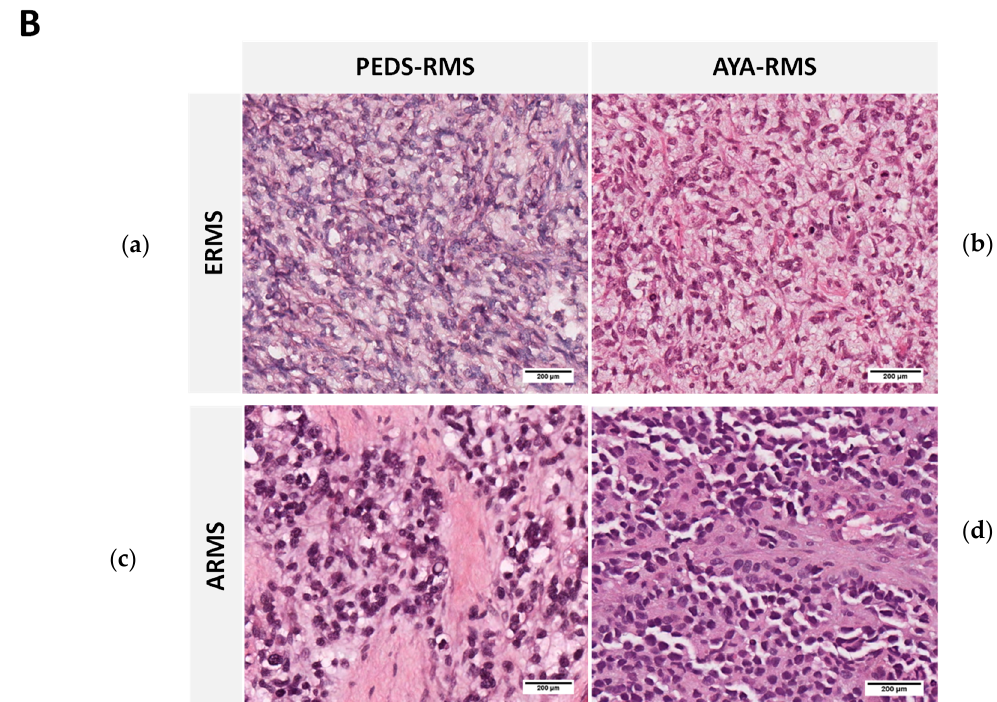
Figure 1. No morphology and histological differences among AYA- and PEDS-RMS. (A) Overall survival, IRS, Histology and Fusion status of the cohort are illustrated in Kaplan-Meier curves. (B) Representative images of a (a) Paratesticular PEDS-ERMS (13 years of age, RMS_26), (b) Paratesticular sample of AYA-ERMS (15 years old, adRMS_5). Similarly, images of (c) of PEDS-ARMS originated from extremities (8 years old, RMS_19), positive for PAX3-FOXO1 fusion transcript with identical histological features as image (d) AYA-ARMS originated in extremities (21 years old, adRMS_12), also positive for PAX3-FOXO1 fusion transcript.